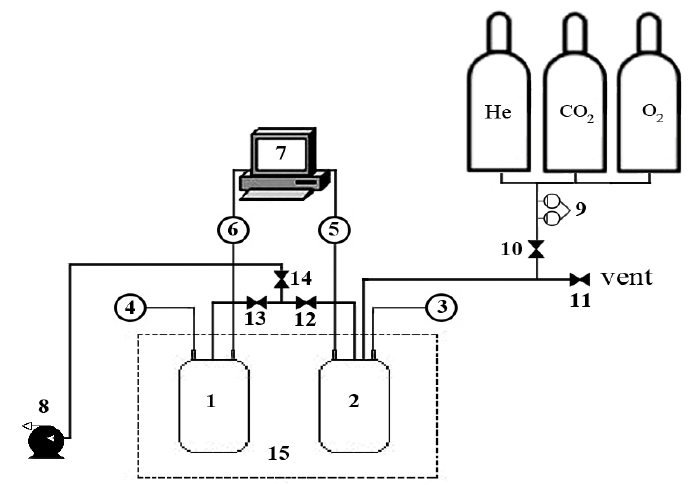
Fig.1. Schematic diagram of the volumetric adsorption set-up: (1) adsorption cell; (2) pressure cell; (3, 4) temperature digital indicator connected to the temperature probe; (5, 6) pressure digital indicator connected to the pressure transducer; (7) recorder; (8) vacuum pump; (9) Regulator; (10-14) valves.